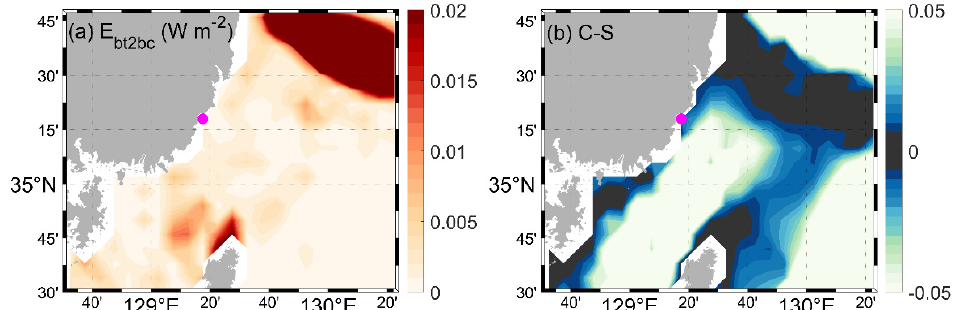
Figure 6. ( a ) Monthly-averaged barotropic to baroclinic energy conversion rate of semidiurnal tides in July 2015; ( b ) difference between the monthly-averaged wave characteristic slope ( C ) of the M 2 internal tide and bottom slope ( S ) in July 2015. The magenta circle indicates the location of the ADCP mooring site.